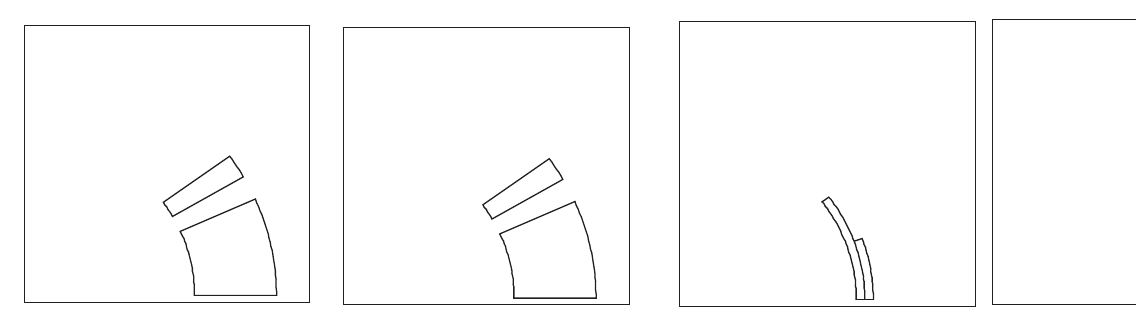
(cid:2) 37 (cid:9) , (cid:7) (cid:2) 20 (cid:9) for 1 2 (cid:2) 35 (cid:9) , (cid:7) (cid:2) 12 : 5 (cid:9) for w=r (cid:2) 0 : 16 1 2 (cid:2) 0 and b 6 10